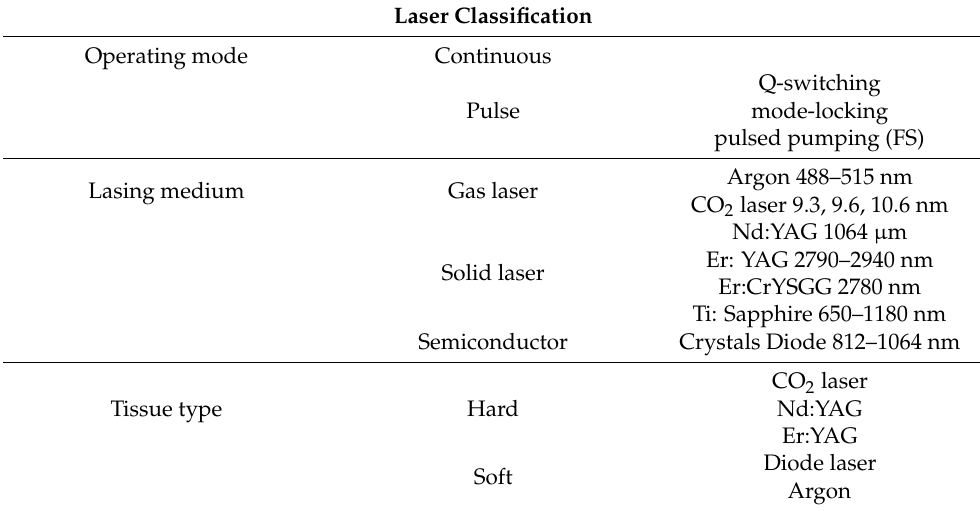
Table 1. Different lasers